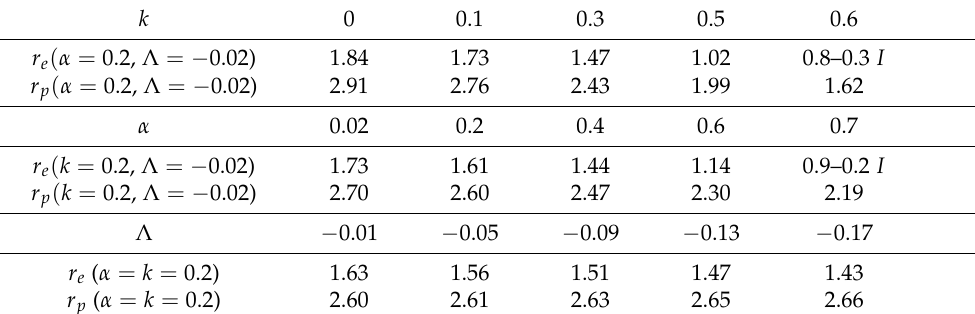
Table 1. Event horizon and photon sphere radius for variation of the cosmological constant, the NED and the GB parameters for the specific case of M =